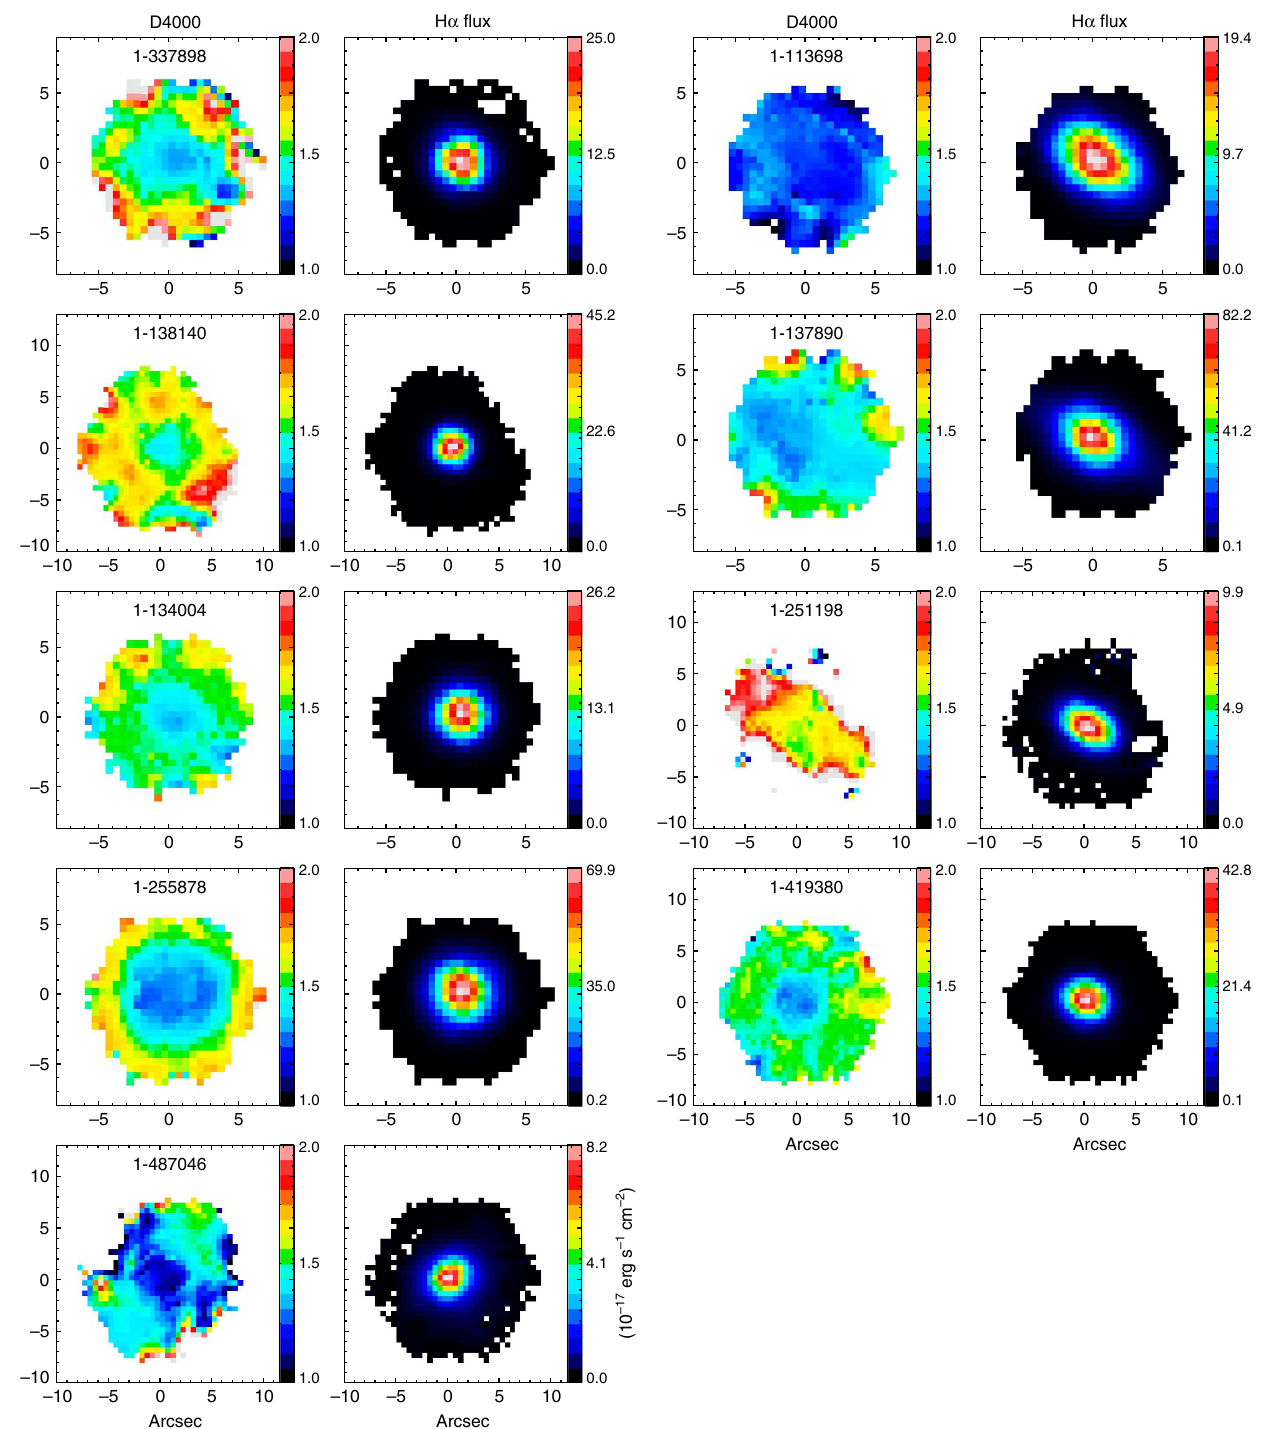
Figure 3 | The D4000 and H a flux maps for nine star-forming counter rotators. The MaNGA-ID for each galaxy is shown in the D4000 map. The H a flux is in the unit of 10 (cid:2) 17 ergs (cid:2) 1 cm (cid:2) 2